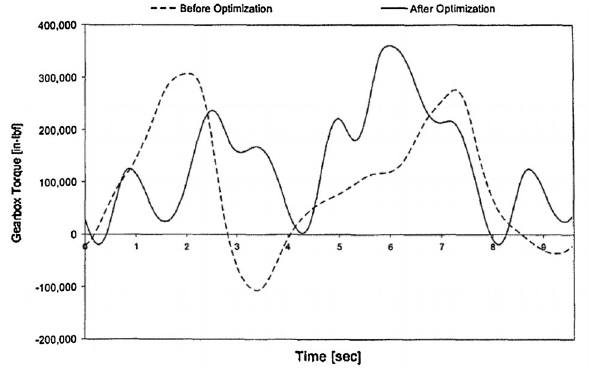
Fig. 17 Gearbox torque after optimization with condition to mini- mize regenerative torque